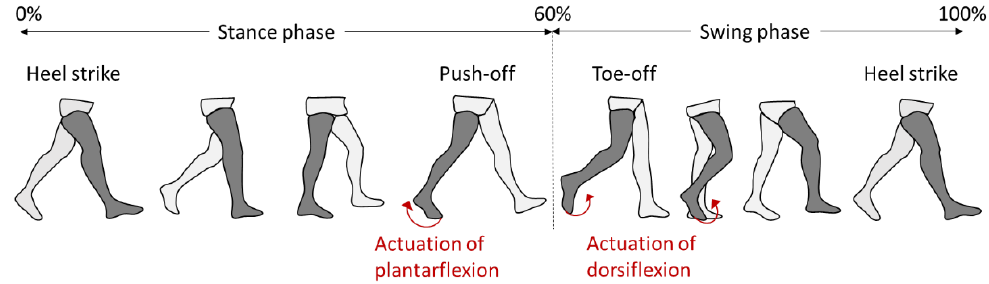
Figure 1. Illustration of supporting function during gait